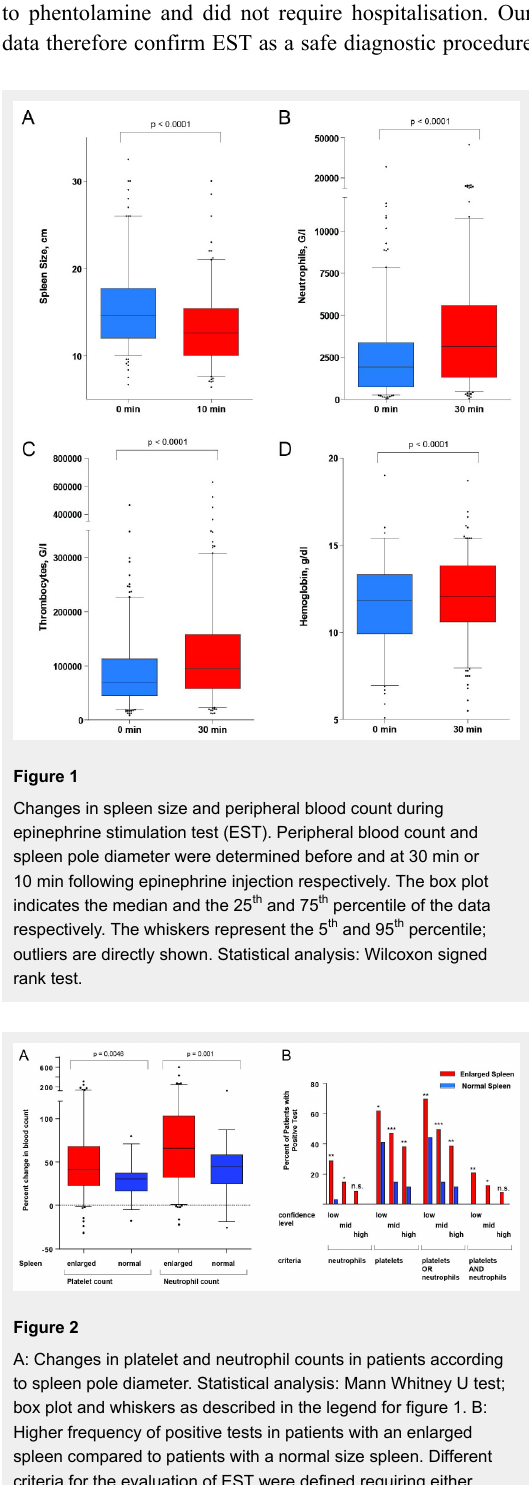
Platelet and neutrophil counts before and after splenectomy according to results of EST. A, B: Thrombocyte and neutrophil counts before and after splenectomy. C, D: Percent change in thrombocyte and neutrophil counts after splenectomy according to the result of EST at different confidence levels. The horizontal lines in the graphs indicate the median of the respective data shown. Significance was calculated using the Wilcoxon signed rank test (A, B) or Mann Whitney U test (C, D)